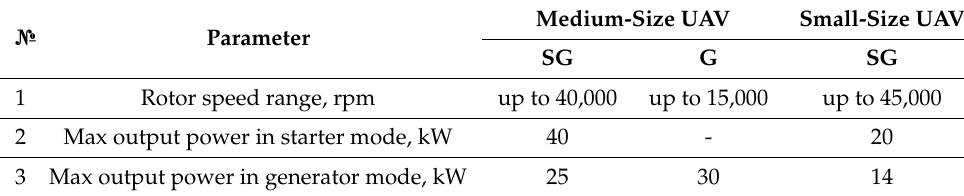
Table 1. SG and G parameters for small and medium size UAV.